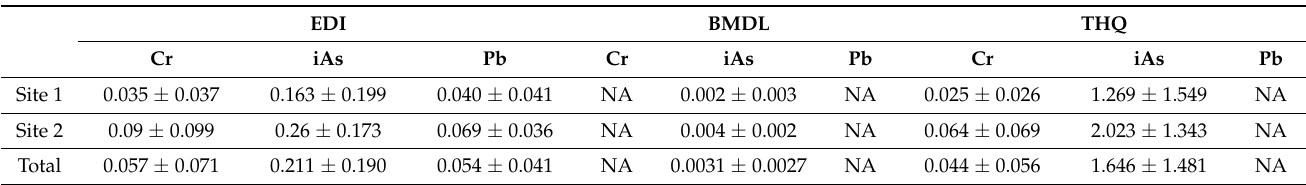
Table 3. Average EDI, BDML and THQ values of the samples analysed sorted by area of pro- duction. Site 1 = samples from Thailand; Site 2 = samples from Vietnam. NA = not applicable; iA = inorganic